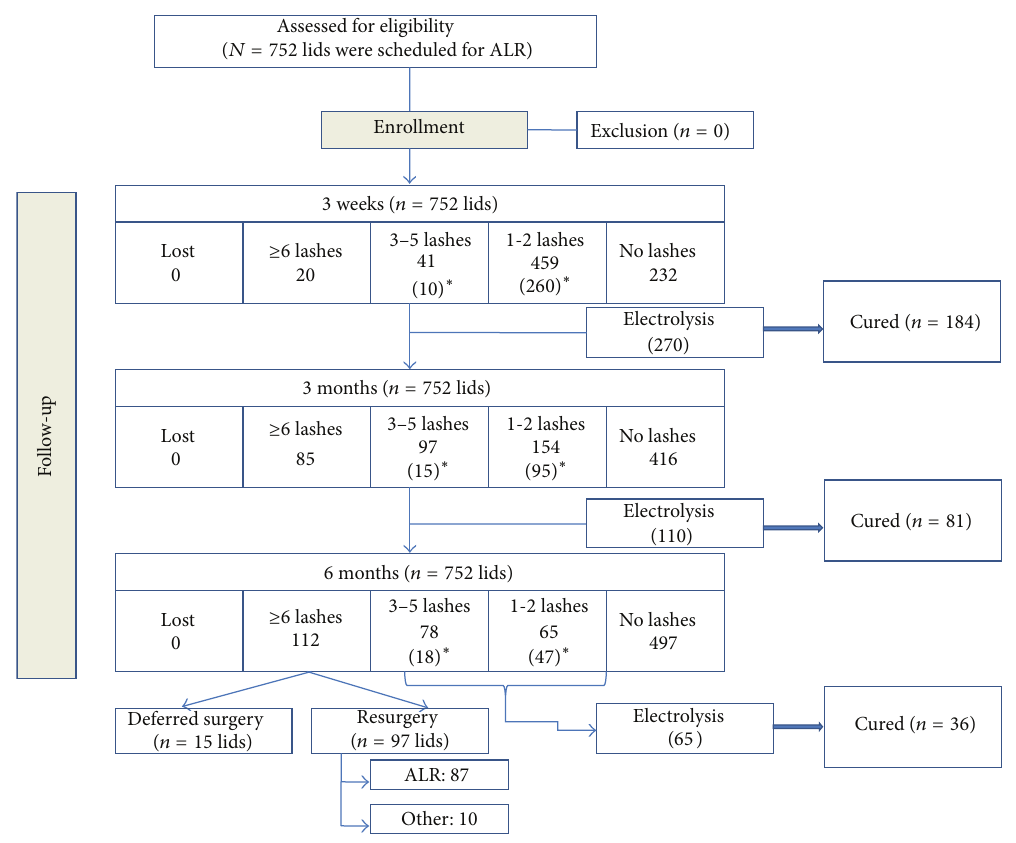
Figure 4: A flow chart illustrating the enrolled lids for intervention and the outcomes per each visit. ∗ The number of lids that were exposed to